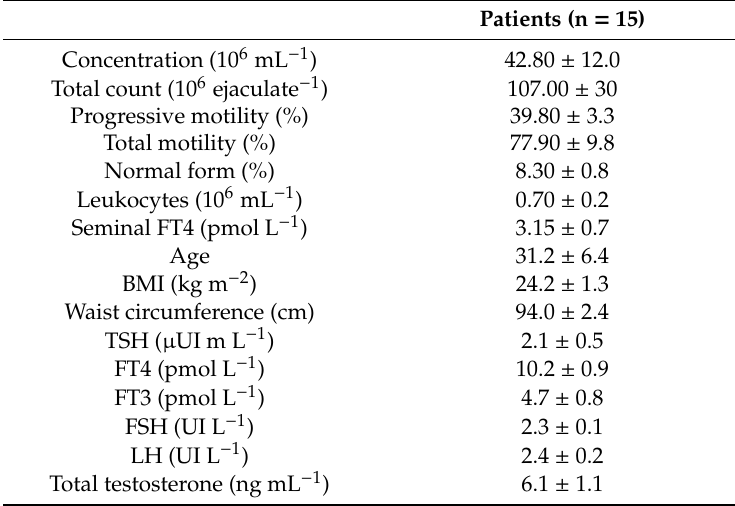
Table 1. Conventional sperm parameters, FT4 seminal measurements, anthropometric parameters and hormone measurements in serum (mean ± SEM) of enrolled